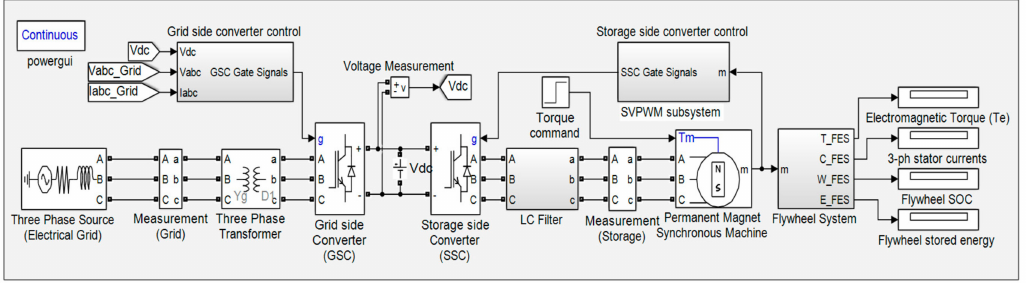
Figure 8. The simplified model of a PMSM operated flywheel connected to an electrical grid.